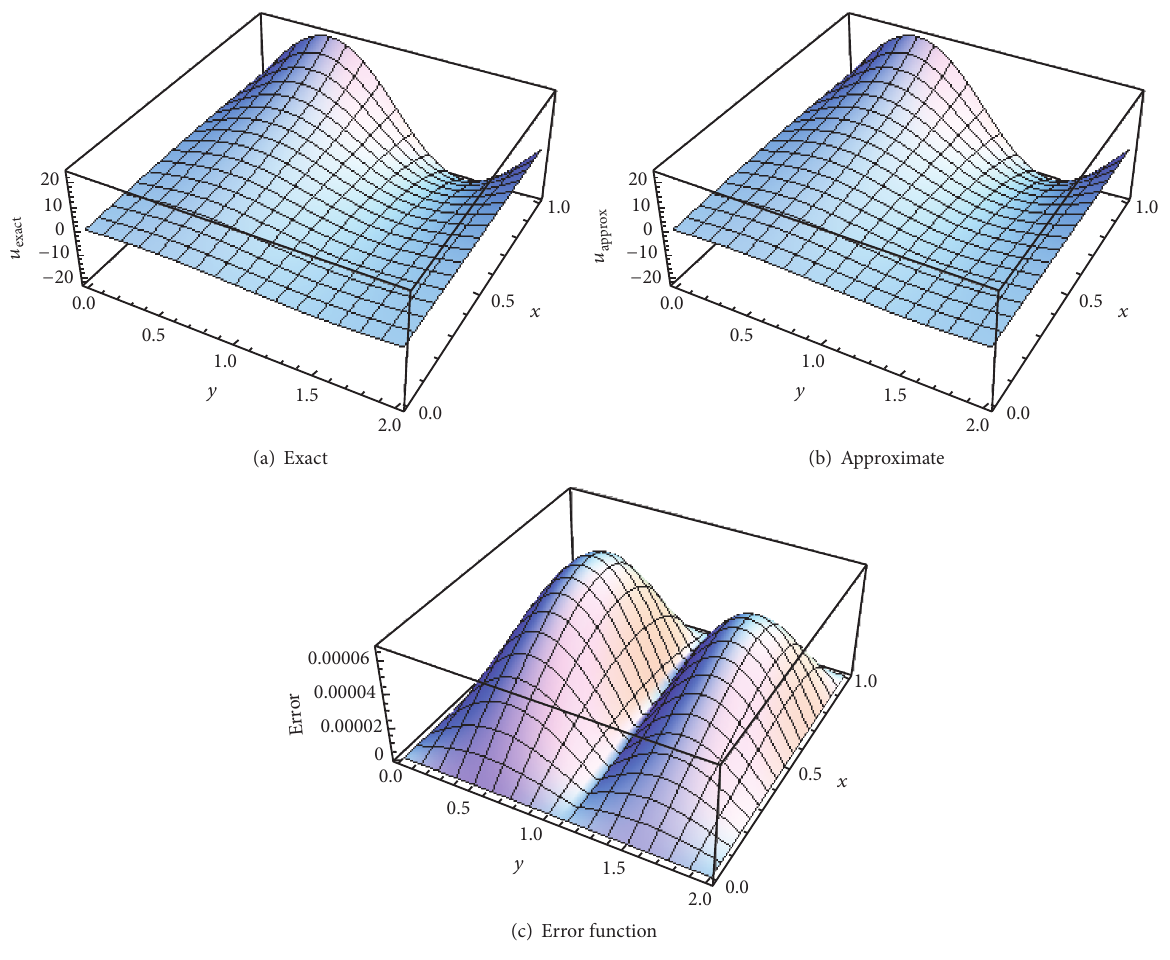
Figure 6: Plot of solution for the Poisson equation. Table 9: Maximum error for the Poisson equation on 𝑦 = 1